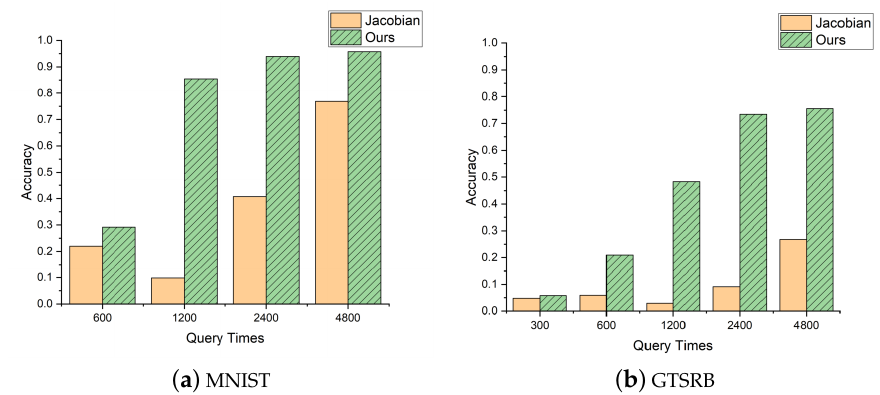
Figure 4. Accuracy of substitute models changes with the query